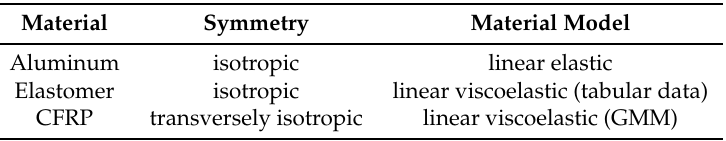
Table 3. Modeling approaches for different material layers in the laminate.